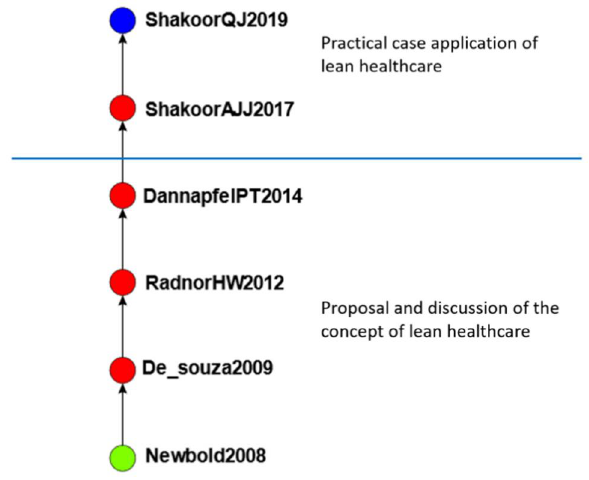
Figure 10. The main path of the fifth group.